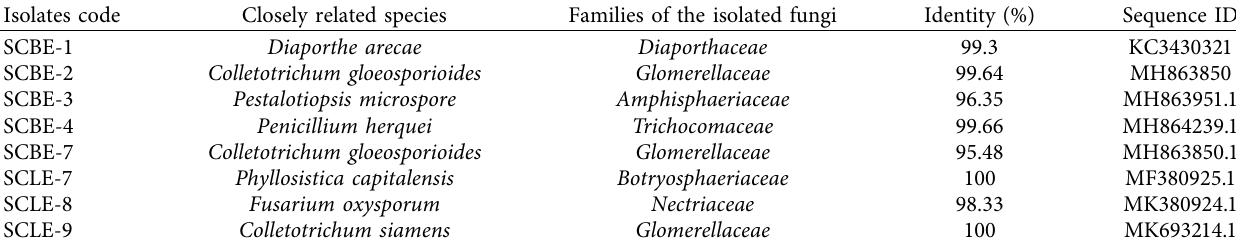
Table 1: NCBI blast results of the fungal isolates recovered from Syzygium cumini .